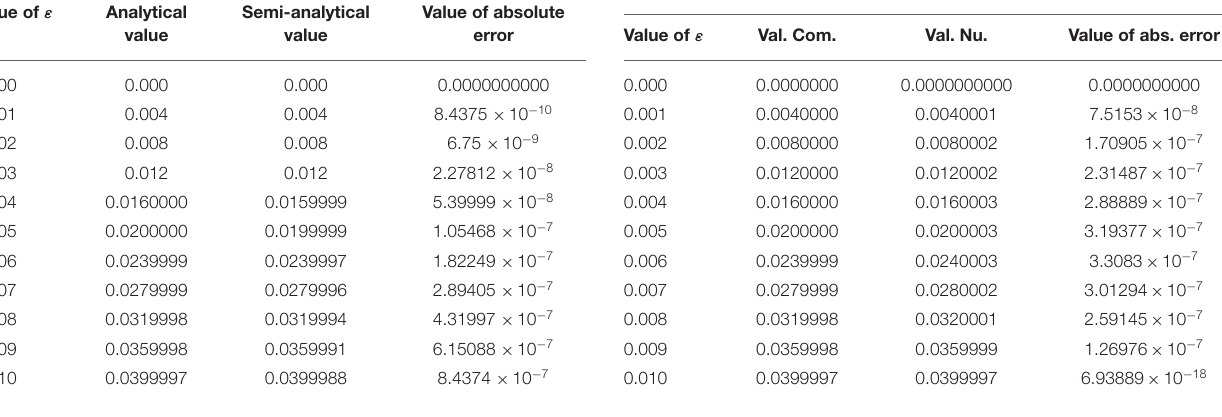
TABLE 3 | Computational, numerical, and absolute error value obtained by using the septic B–spline